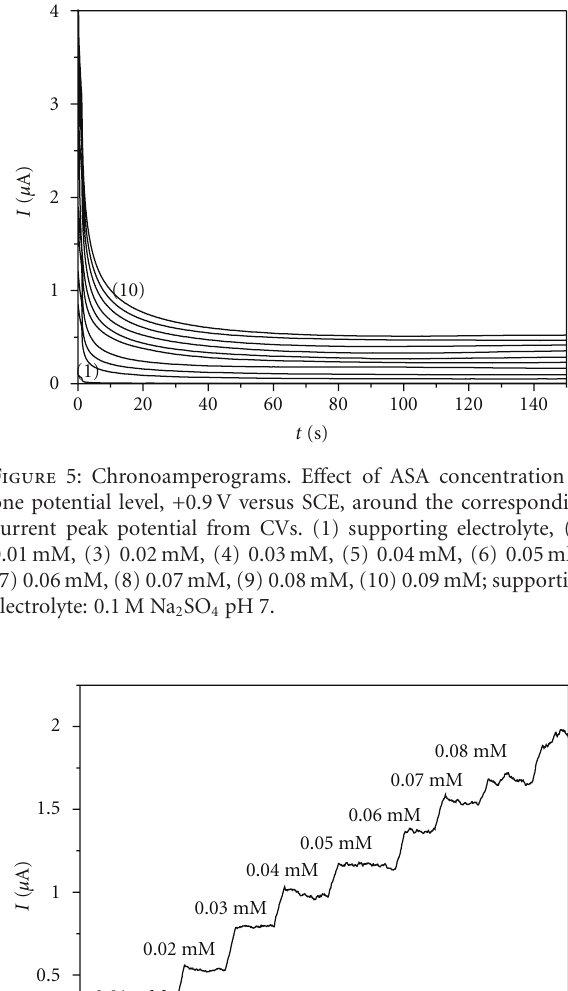
Figure 4: (a) Di ff erential pulse voltammograms. (1) supporting electrolyte; (2) 0.2/50 dilution of Aspirin initial solution in sup- porting electrolyte; (3) 0.2/50 dilution of Aspirin initial solution in supporting electrolyte and ASA addition, 0.01mM ASA final supplementary concentration; (4) 0.2/50 dilution of Aspirin initial solution in supporting electrolyte and ASA addition, 0.02mM ASA final supplementary concentration; supporting electrolyte: 0.1M Na 2 SO 4 pH 7. (b) Di ff erential pulse voltammograms. (1) supporting electrolyte; (2) 0.2/50 dilution of Acid Acetilsalicilic initial solution in supporting electrolyte; (3) 0.2/50 dilution of Acid Acetilsalicilic initial solution in supporting electrolyte and ASA addition, 0.01mMASA finalsupplementary concentration;(4) 0.2/50 dilution of Acid Acetilsalicilic initial solution in supporting electrolyte and ASA addition, 0.02mM ASA final supplementary concentration; supporting electrolyte: 0.1M Na 2 SO 4 pH 7.